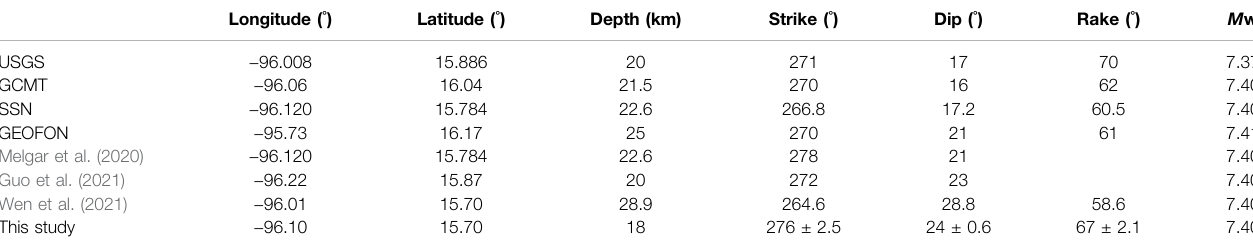
TABLE 1 | Comparisons of the earthquake parameter of the 2020 Oaxaca Earthquake with different